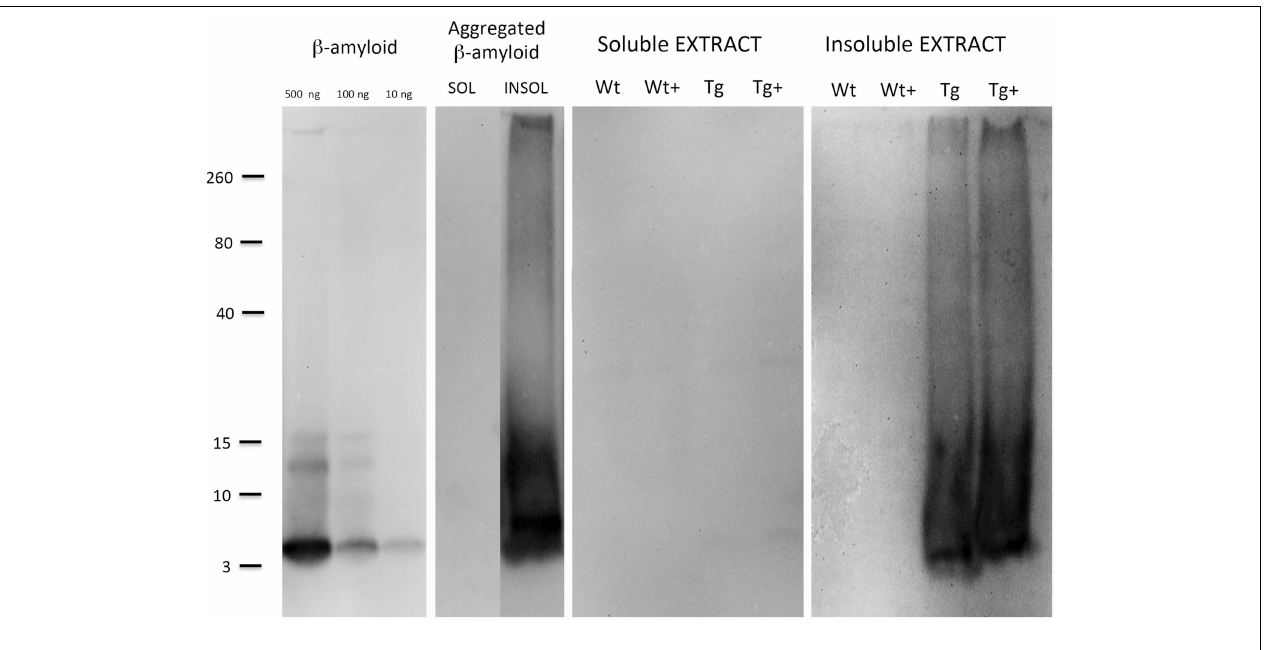
FIGURE 6 | Western Blot analysis of brain slice extracts. Beta-amyloid (10–100–500 ng per lane), or aggregated beta-amyloid (2w 4 ◦ C + 2w 37 ◦ C) or slice extracts (either soluble or insoluble extracts) were loaded onto gels, separated for 25min, blotted with 20% methanol and analyzed for